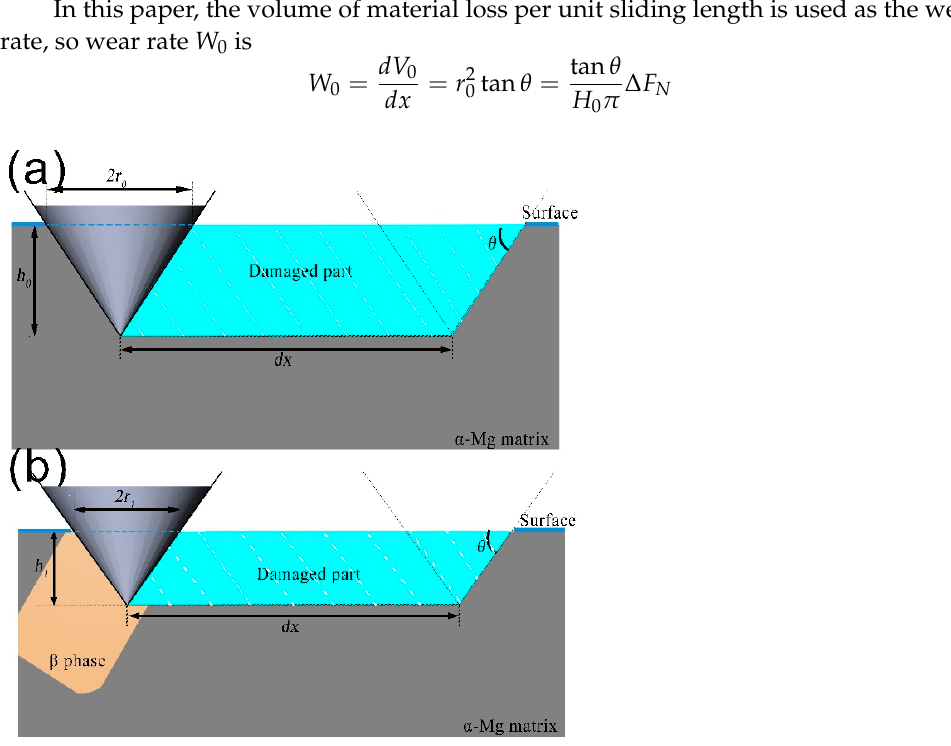
Figure 12. Schematic diagram of plowing groove formation under the sliding action of a rigid cone: ( a ) Rigid cone in contact with pure Mg matrix, ( b ) Rigid cone in contact with hard β -phase. In addition to magnesium matrix, the surfacing AZ91 alloy also contains many net-like β -phases. A nanoindentation experiment conducted by Gupta et al. [26] showed that the hardness of the β -phase is about four-times that of the magnesium matrix, 3.8 ± 0.3 GPa versus 1.4 ± 0.1 GPa, respectively. Therefore, during the wear process, coarse hard net-like β -phases can effectively prevent hard microscopic protrusions from being pressed into the matrix. This can protect the matrix to a certain extent, as shown in Figure 12b. The volume of debris produced by the plowing action